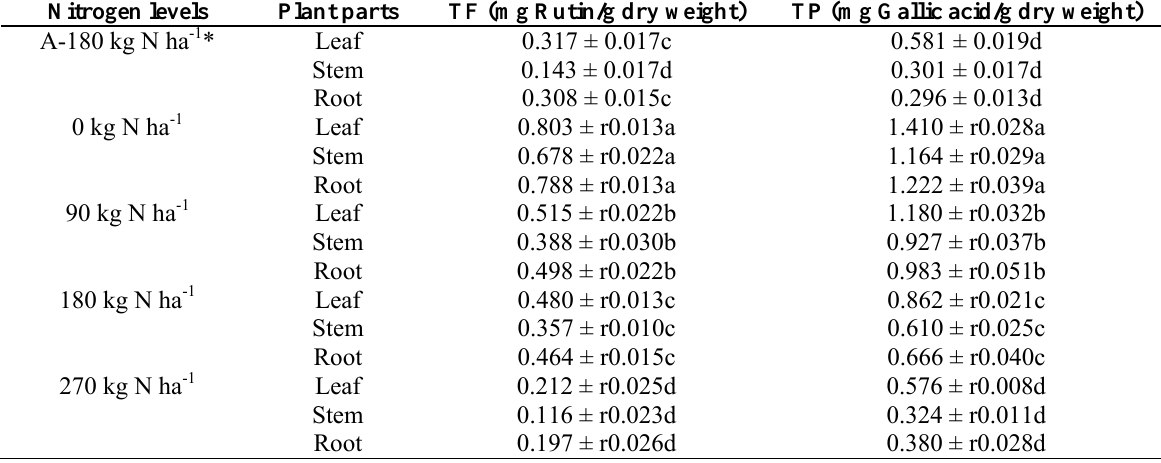
Table 1. Accumulation and partitioning of total flavonoids (TF) and total phenolics (TP) in different plant parts of Labisia pumila Benth. under different combinations of nitrogen levels and CO 2